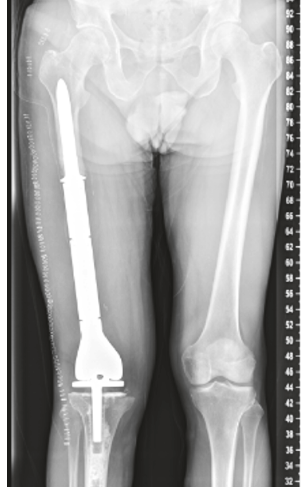
Figure 4: Postoperative AP radiograph with endoprosthesis recon-